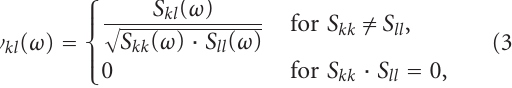
Figure 6: Connection between girder and cap-beam (frictional